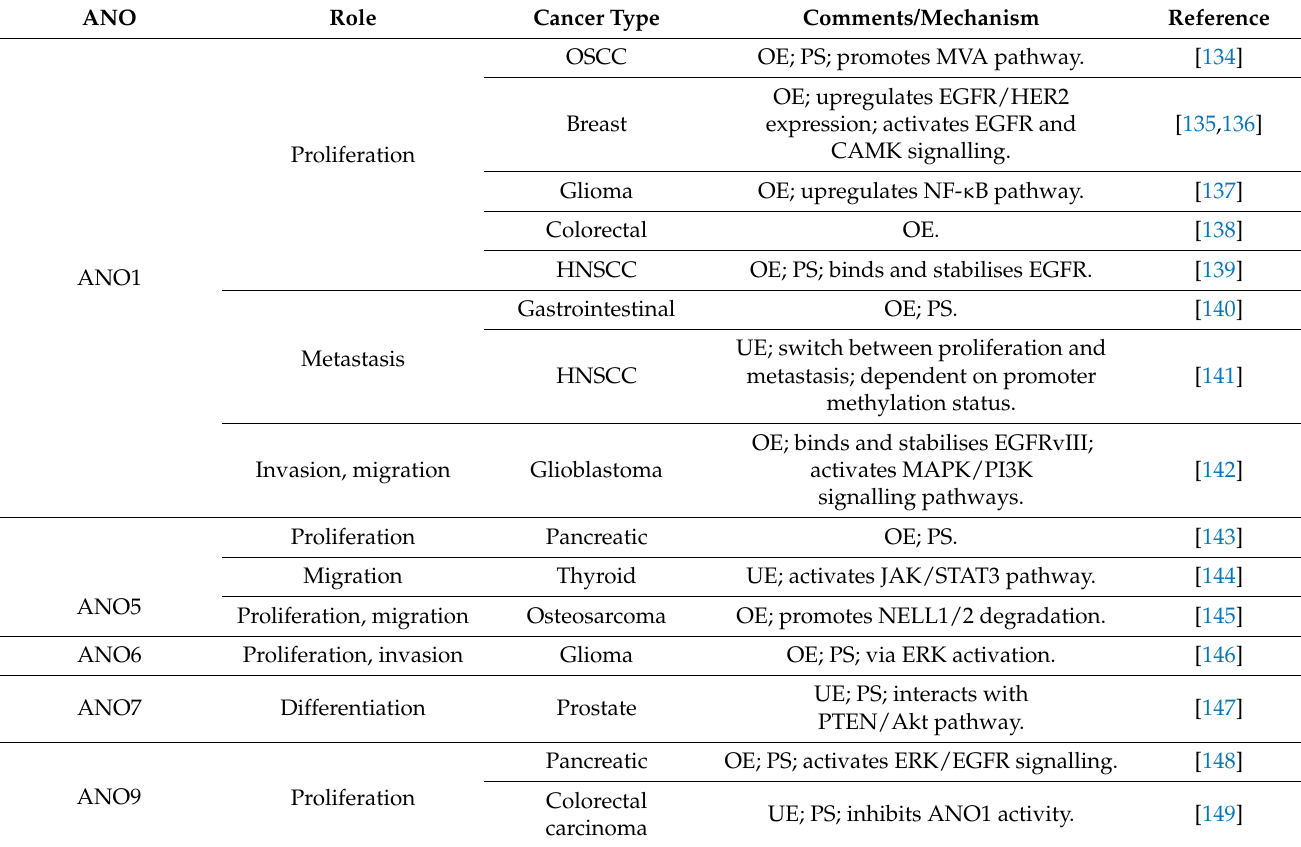
Table 2. ANOs in